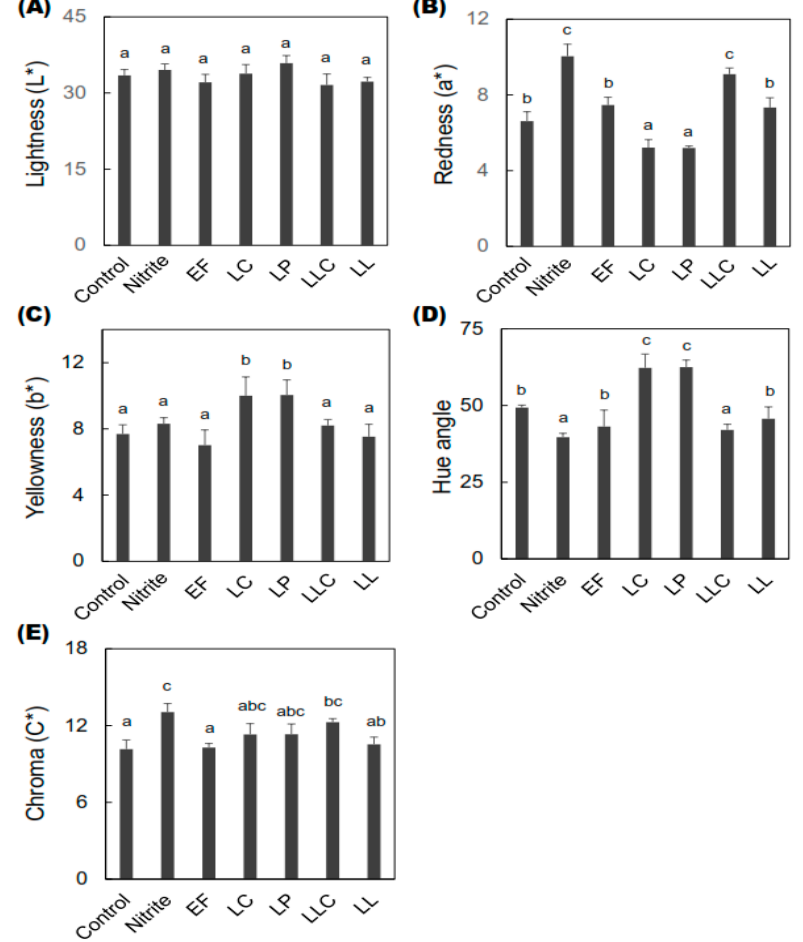
Figure 3. Effects of high ZnPP-forming LAB on the external color profiles of dry-cured fermented sausages. CIE (Commission internationale de l'éclairage) L* (lightness), a* (redness), b* (yellowness), hue angle, and chroma values of the fermented sausages were measured after 28 days of ripening. The figures indicate ( A ) lightness (L*), ( B ) redness (a*), ( C ) yellowness (b*), ( D ) hue angle, and ( E ) chroma (C*) values of the sausages at the end of ripening. Bars represent standard errors ( n = 2). a–c: columns with di ff erent letters in the di ff erent groups di ff er significantly ( p < 0.05). ZnPP: zinc protoporphyrin IX, LAB: lactic acid bacteria, EF: Enterococcus faecium , LC: Lactobacillus curvatus , LP: Lactobacillus plantarum , LLC: Lactococcus lactis subsp. cremoris , LL: Leuconostoc